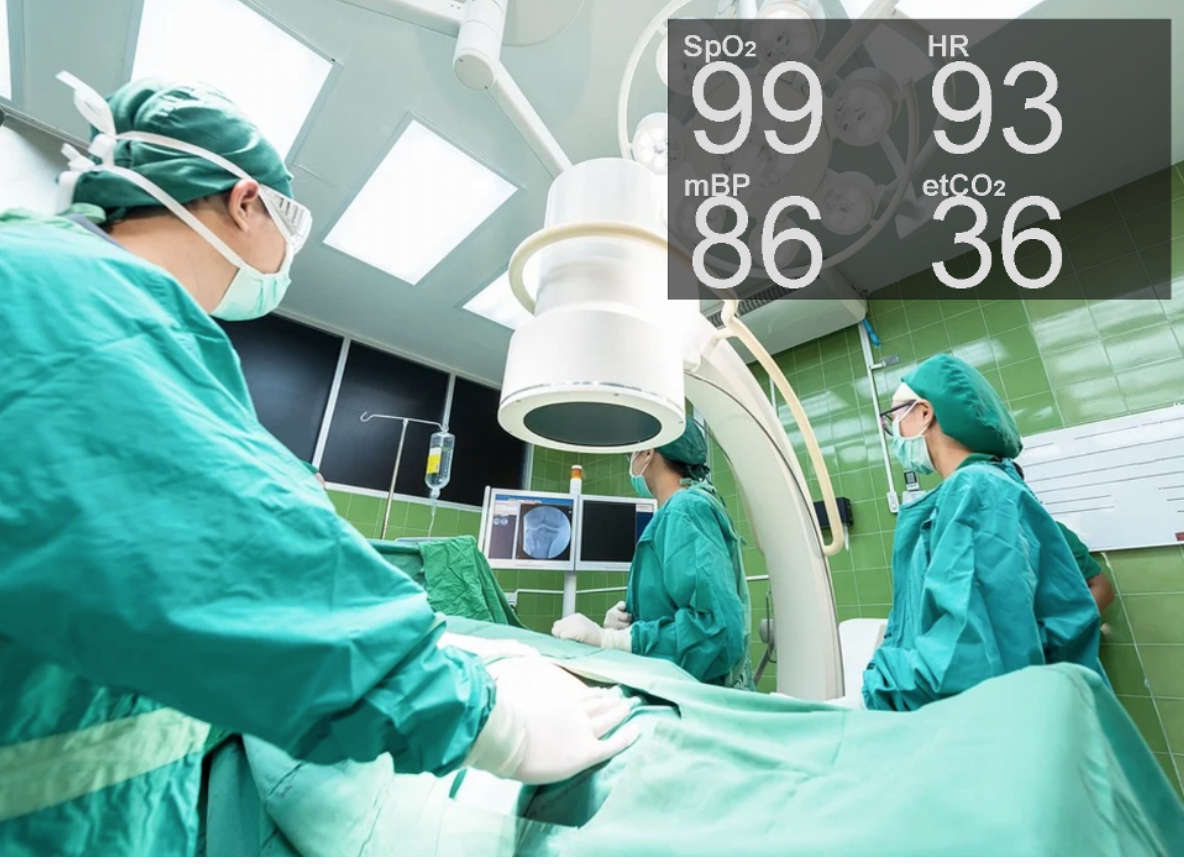
Figure 16. A mock-up of the views experienced by anesthetists in the study by Drake-Brockman et al [37] (a model of the concept presented in the paper). EtCO2: end-tidal carbon dioxide partial pressure; HR: heart rate; mBP: mean blood pressure; SpO2: oxygen